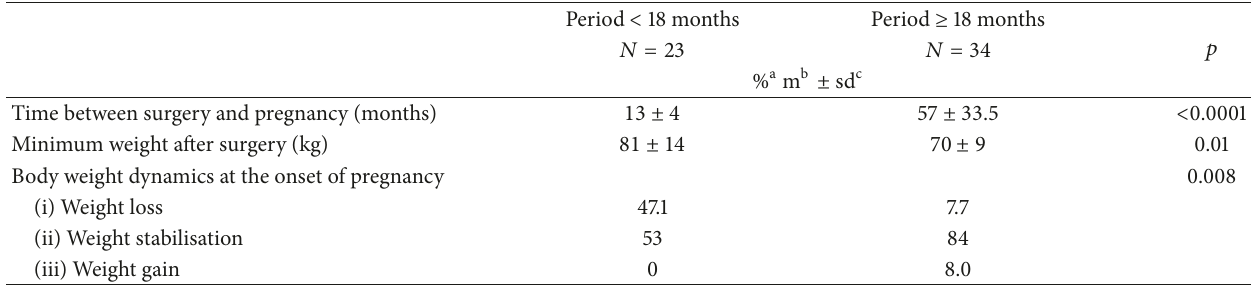
Table 6: Maternal and pregnancy-related characteristics according to the time between bariatric surgery and